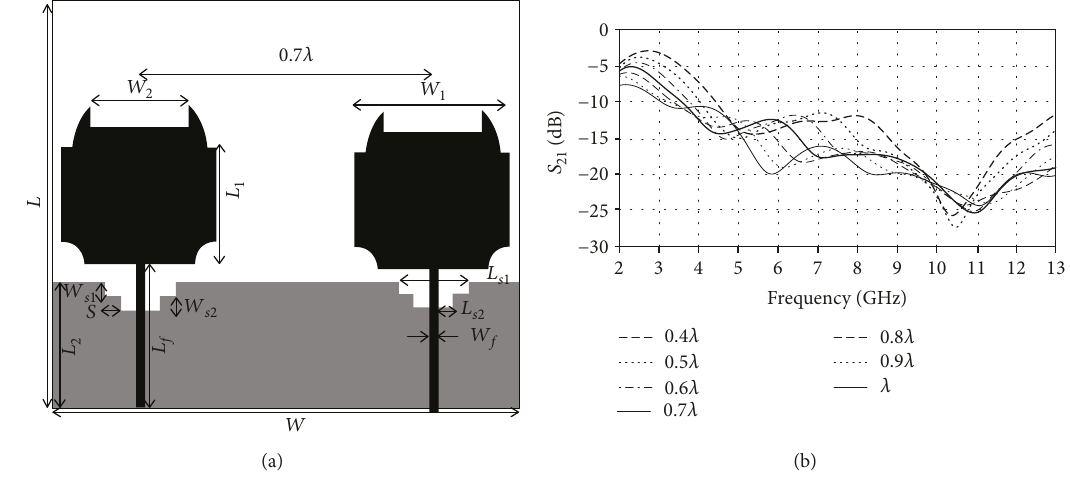
Figure 4: (a) MIMO antenna I. (b) S